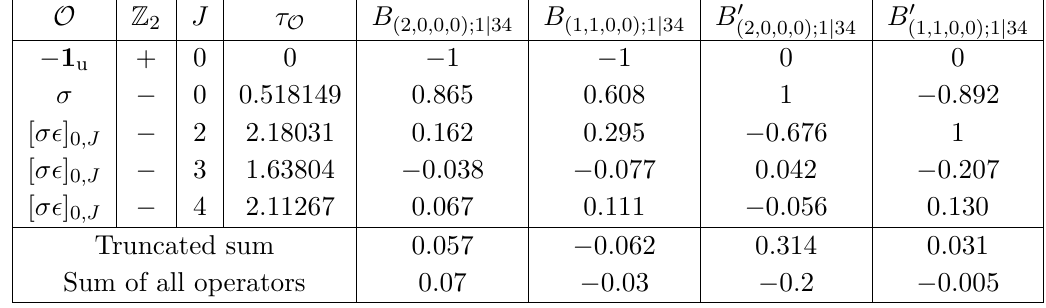
Table 7 . Contribution of each operator to the h (cid:15)σ(cid:15)σ i sum rule with v = 1 normalized relative to the largest contributor of the sum rule; these results include the contribution of the OPE coefficient square ( − 1) J f 2 . Sum rules from these subtracted functionals should add up to 0 in accordance (cid:15)σ O with eq. (5.4). Other operators contribute at order O (10 − 2 ) and smaller; we show the [ σ(cid:15) ] operator to illustrate the negativity for odd spin operators in these sum